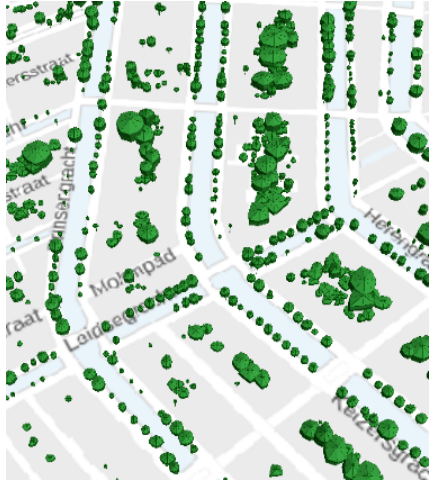
Figure 7. Amsterdam City Center